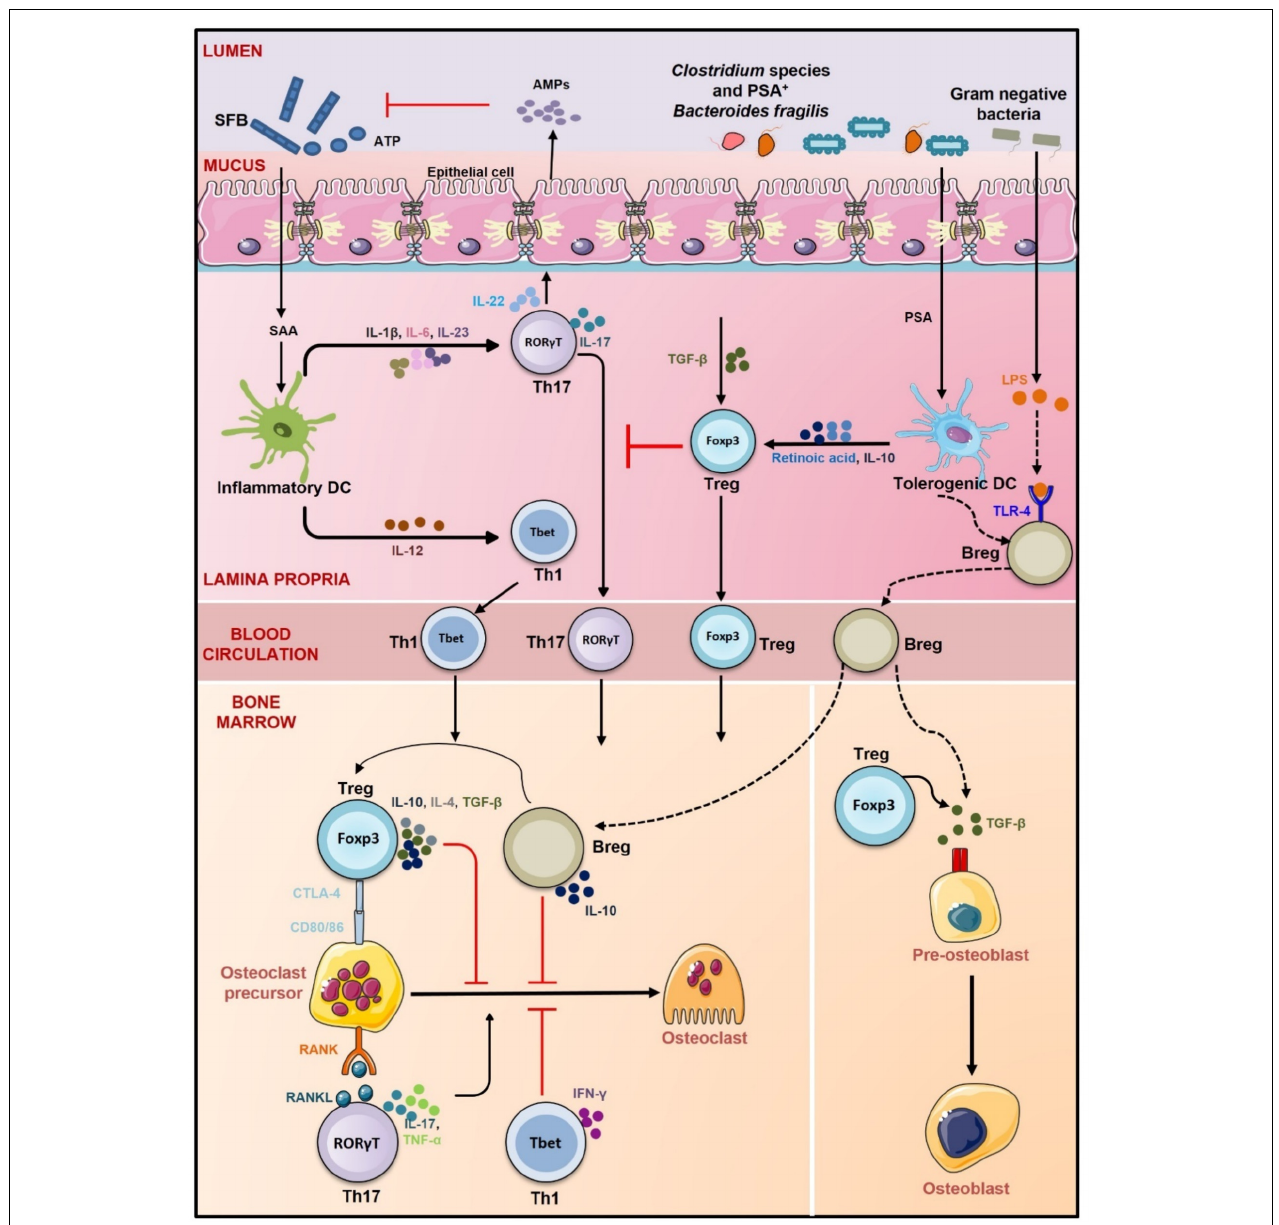
FIGURE 4 | Gut-Immune-Bone axis. GM promotes the development of Treg, Th1 cells, Breg, and Th17 cells. Clostridium species, Bacteroidetes fragilis, and gram-negative bacteria promote differentiation of Tregs and Bregs via inducing tolerogenic DCs whereas segmented filamentous bacteria (SFB) through induction of inflammatory DCs stimulate differentiation of Th17 cells (role of SFB in inducing Th17 cells is observed in mice only). Tregs, Bregs, and Th1 cells prevent osteoclastogenesis via CTLA-4, IL-10, IL-4, TGF- β , and IFN- γ , respectively. Th17 cells on the other hand promote osteoclastogenesis by secreting IL-17, RANKL, and TNF- α . Tregs also induce differentiation of osteoblasts via TGF- β . Bregs also secrete TGF- β and thus like Tregs might also regulate osteoblastogenesis. By promoting the development of both anti-osteoclastogenic and osteoclastogenic cells, GM regulates the balance between bone formation and resorption and thus maintains bone homeostasis lines represent proposed mechanism of